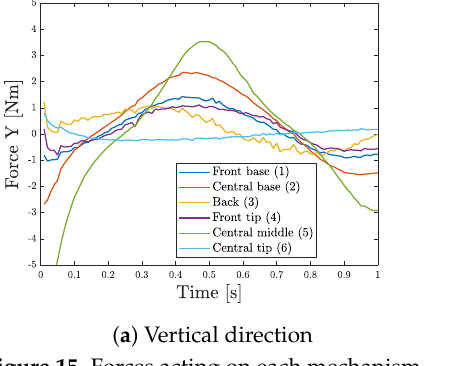
Figure 15. Forces acting on each mechanism.